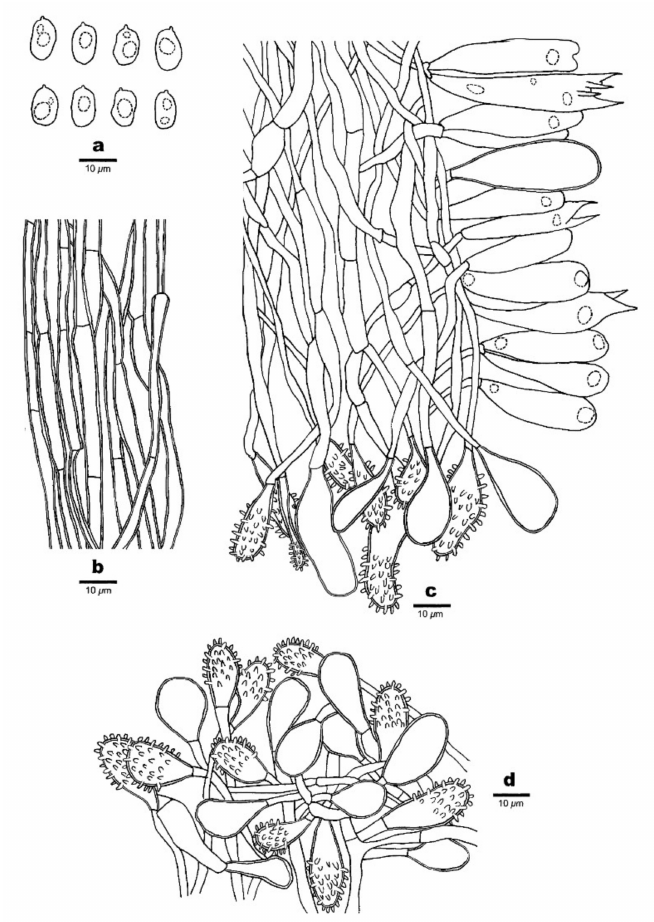
Figure 9. Microscopic structures of Favolaschia claudopus (Dai 18656, holotype). ( a ) Basidiospores. ( b ) Medullary hyphae of the stipe. ( c ) Hyphae at edge of pores showing gloeocystidia, acanthocystida, basidia and basidioles. ( d ) Hyphae of pleus cortex, composed of a hymeniform layer of acanthocysts and